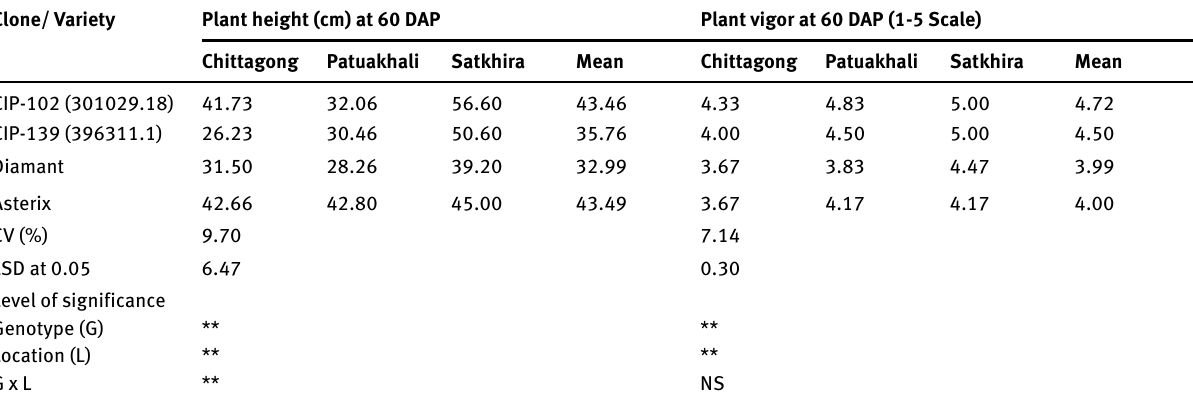
Table 3: Plant height and vigor at 60 DAP of the 2 most promising CIP potato clones and check varieties at 3 saline locations in Bangladesh during the 2014-15 crop